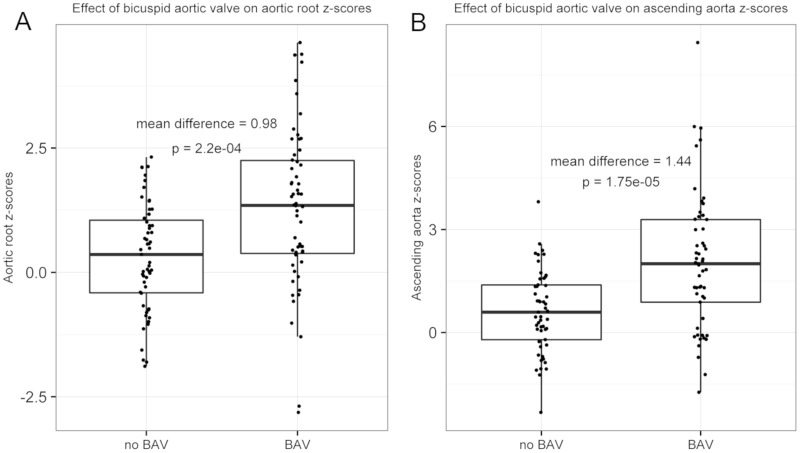
Aortic z-scores are associated with BAV in the Turner syndrome discovery cohort.Box plot of A) AR z-scores and B) AAO z-scores for individuals with and without a BAV, where both were significantly associated with the presence of a BAV, p = 0.0002 and p<0.0001, respectively.